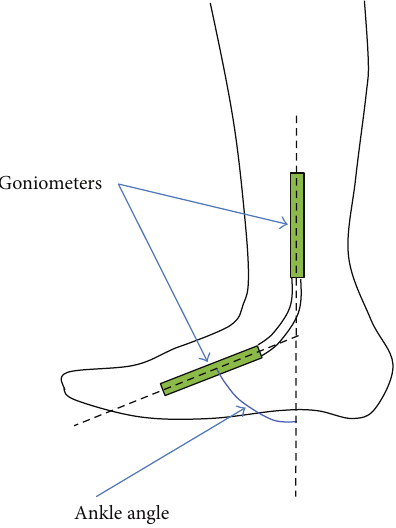
Figure 10: Goniometer attached to the ankle of a